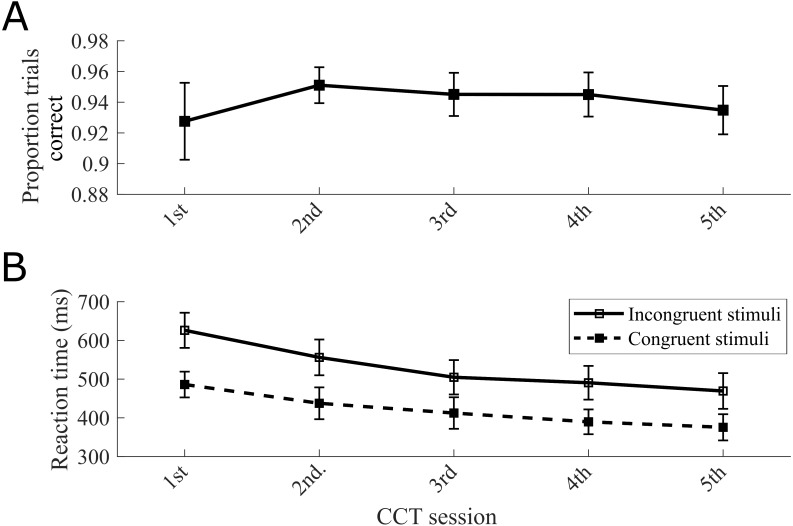
Decreasing CCE score trend matched in isolated reaction times but not in CCT correct trial rate.(A) Plot of proportion correctly selected trials over repeated exposures. An incorrect trial occurred when the wrong pedal was pressed (e.g., vibration stimulus on the thumb resulted in subject pressing the pedal indicating an index finger stimulus). (B) Congruent and incongruent reaction times plotted independently. Results from Experiment 1.